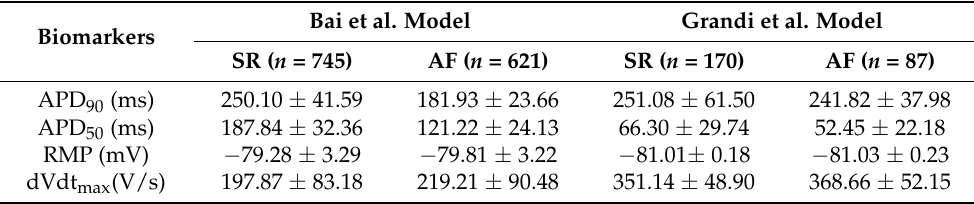
Table 5. AP biomarkers obtained from the Bai et al. model and the Grandi et al. model under atrial fibrillation (AF) and sinus rhythm (SR) conditions.